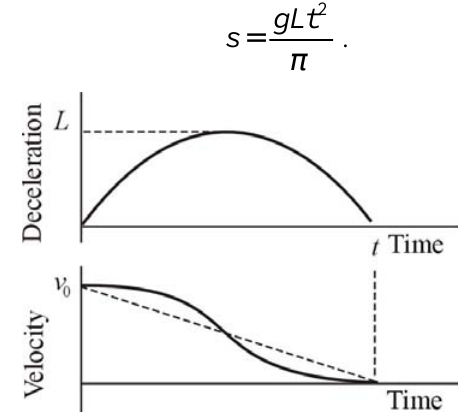
Fig 11. Rate of deceleration with a half-sine form A dependence of the following equations is shown in the Fig 12. In Fig 12 we can see that stopping distance is shortest when a rate of deceleration has a rectangular form.